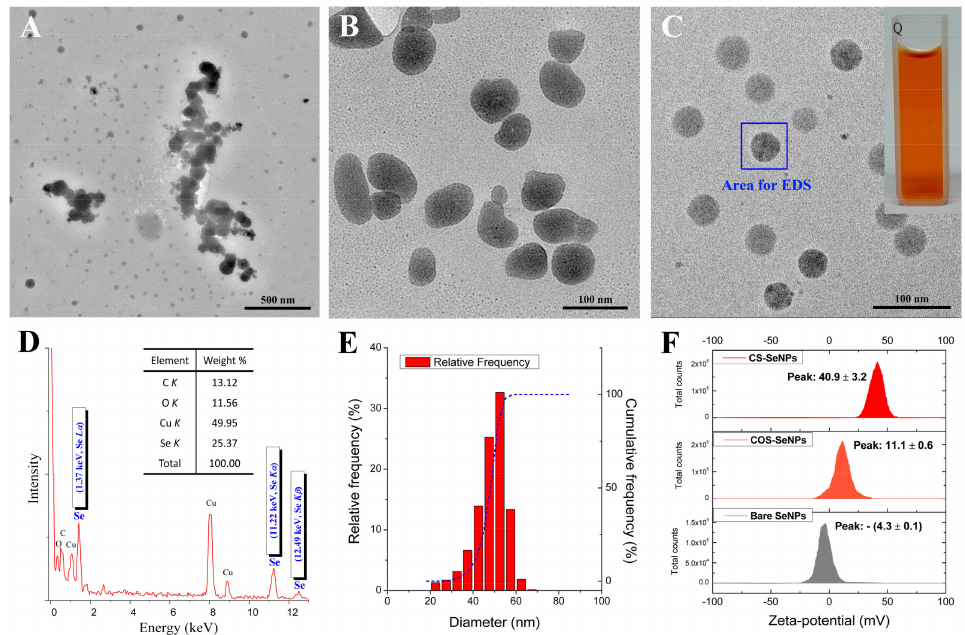
Figure 1. Typical morphology and formation of selenium nanoparticles (SeNPs). TEM images of ( A ) bare SeNPs, ( B ) chitooligosaccharide (COS)-SeNPs, and ( C ) chitosan (CS)-SeNPs. ( D ) EDS spectra of CS-SeNPs determined from the area shown in Figure 1C. ( E ) The size distribution of CS-SeNPs measured from the TEM results. ( F ) Zeta-potentials of bare SeNPs, COS-SeNPs, and CS-SeNPs, measured at a pH of 5.0 ±